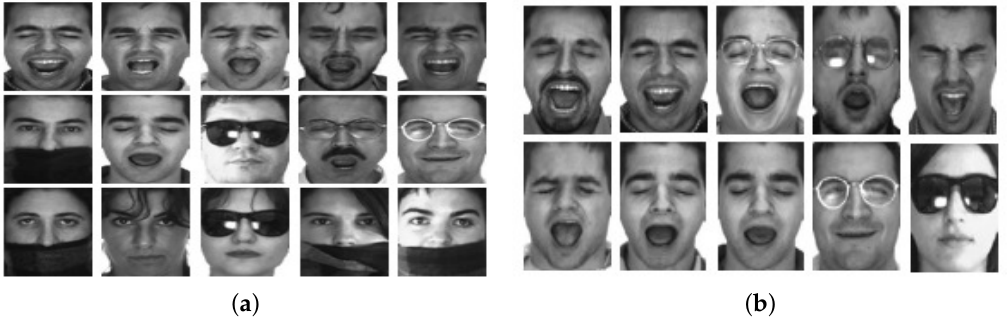
Figure 9. All misclassified images produced by ( a ) LAMP and ( b )